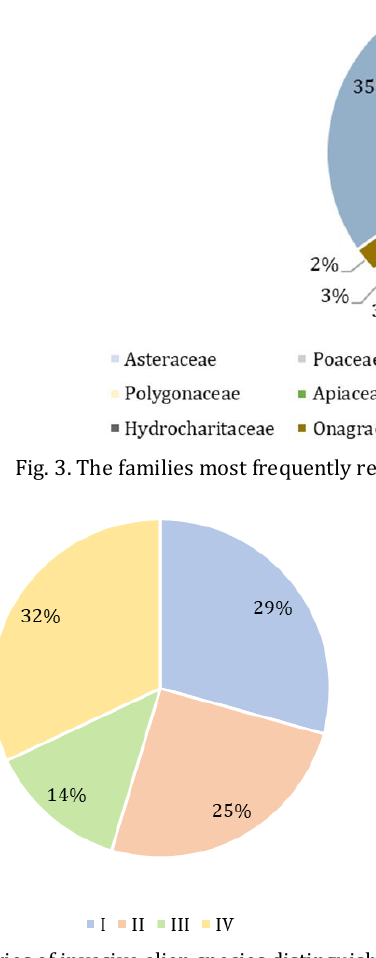
Fig. 4. Categories of invasive alien species distinguishing to sum of scores (after Tokarska-Guzik et al.,